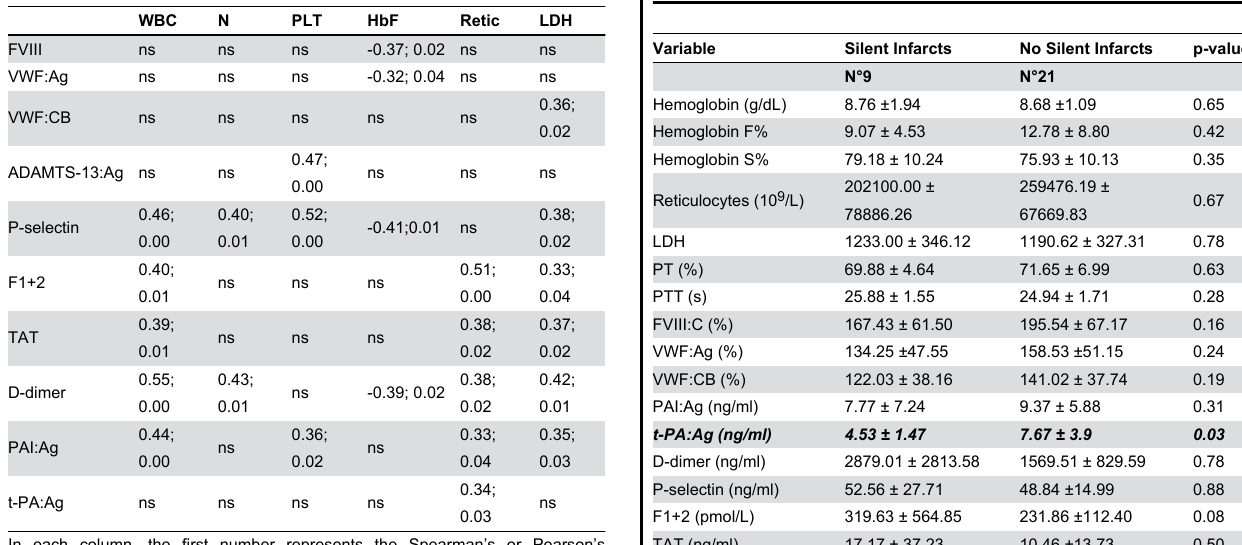
Table 4. Comparison of mean haematological and coagulation variables ± SD between SS- Sβ° patients with Silent Infarcts and without Silent